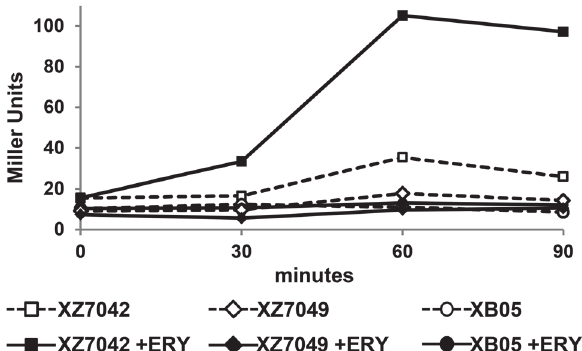
Fig 2. β -galactosidase activity of promoter mutations in the mef(E)-lacZ reporter locus. XZ7042 (squares) is the reporter strain generated by insertion of a mef(E)-lacZ fusion into the pneumococcal β - galactosidase gene bgaA ; XZ7049 (diamonds), promoterless lacZ strain; XB05 (circles), strain containing the mef(E) promoter region deletion ( Δ -41-(-5)) in the mef(E)-lacZ fusion in the bgaA locus. Dashed lines and open symbols, non-inducing conditions; solid lines and closed symbols, inducing conditions (treated with erythromycin at a concentration equal to 10 -1 erythromycin MIC). Bars represent the standard error of the mean (SEM) of experiments performed in duplicate.